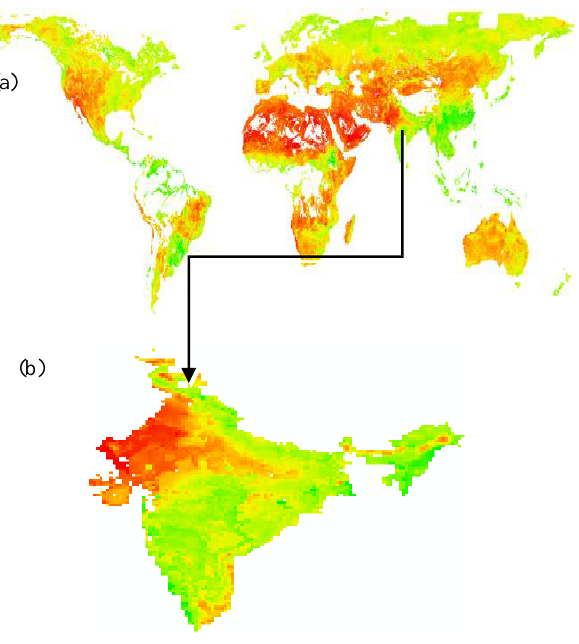
Figure 2: a) Global soil moisture data, and b) subset of data covering Indian region.